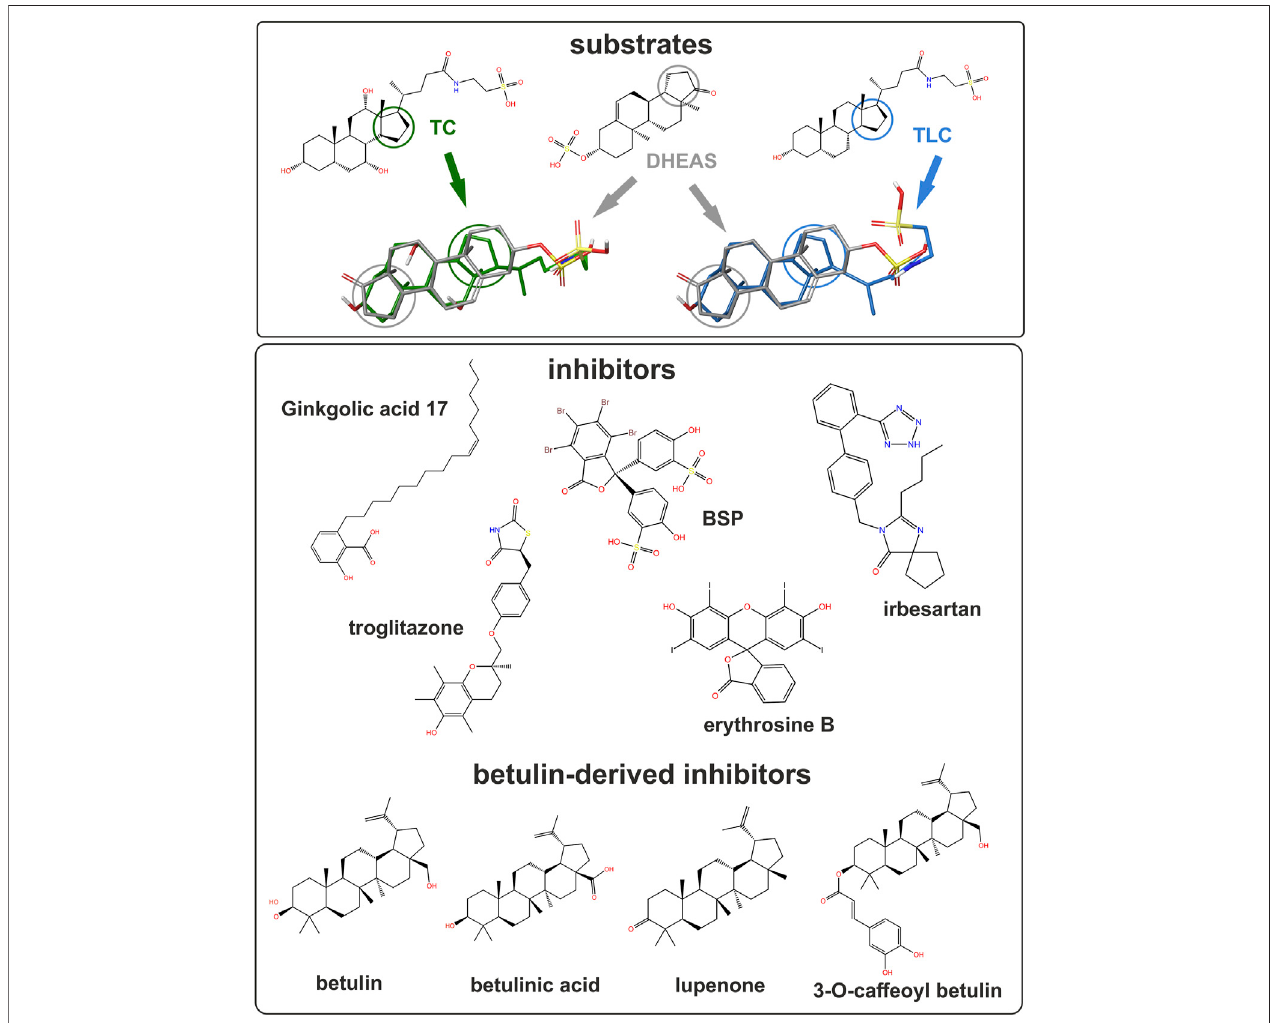
FIGURE 8 | Structure of studied substrates and inhibitors. Selected compounds shown for structural comparison as 2D structure formula (PubChem ID - CID). Substrates:taurocholicacid-TC(CID6675),taurolithocholicacid-TLC(CID439763)andDHEAS(CID12594).Inhibitors:ginkgolicacid17:1(CID5469634),BSP(CID5345), irbesartan(CID3749),troglitazone(CID5591) and erythrosineB(CID3259).Betulin-derivedinhibitors:betulin(CID72326),betulinicacid(CID64971),lupenone(CID92158)